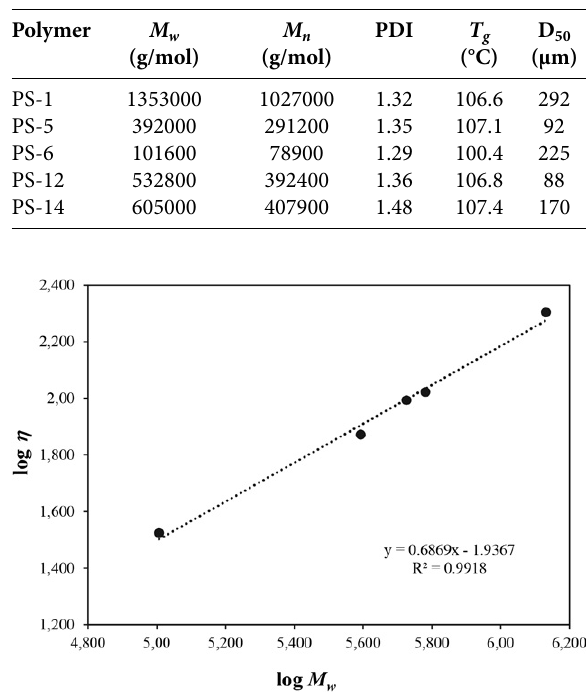
Fig. 5. Change of log M w of the polymers with the change of log η